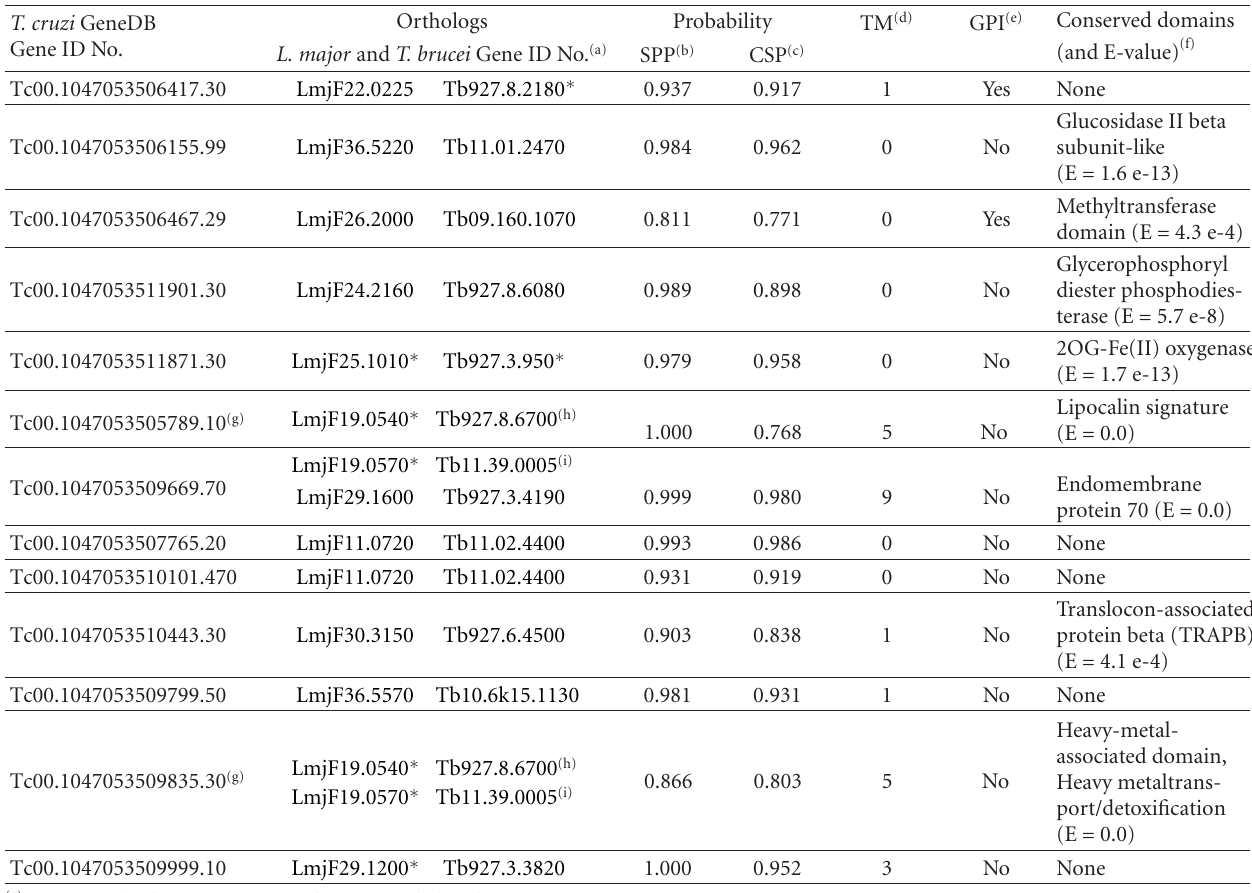
Table 2: T. cruzi genes selected by in silico analysis and predicted properties of the encoded hypothetical proteins. T. cruzi GeneDB Gene ID